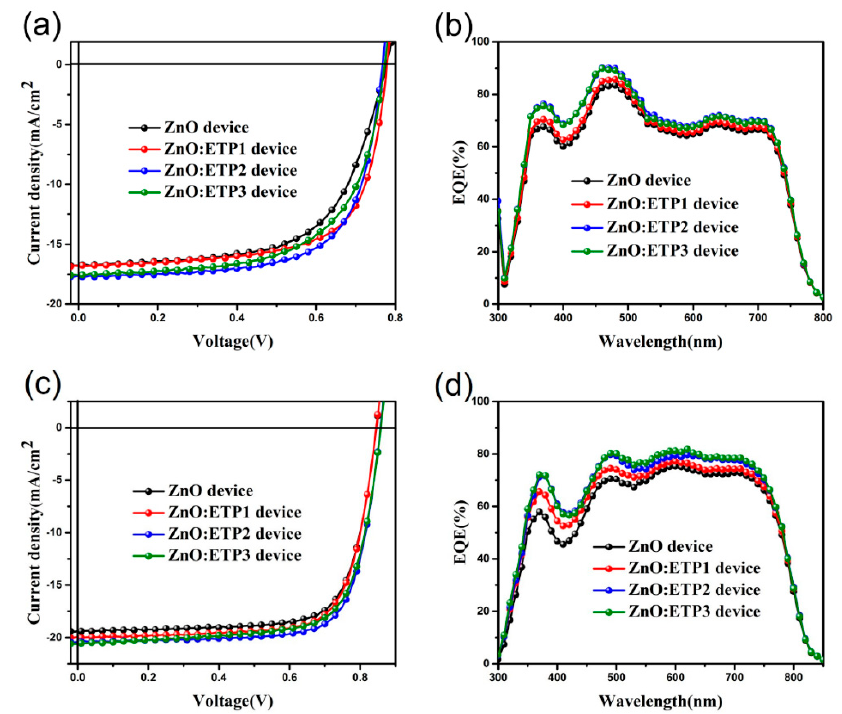
Figure 7. ( a,c ) Current density versus voltage characteristics; ( b,d ) external quantum efficiency (EQE) curves of devices based on PTB7-Th–PC 71 BM and PBDB-T-2F–IT-4F using ZnO and ZnO/ETP (different concentrations) as cathode buffer layers.